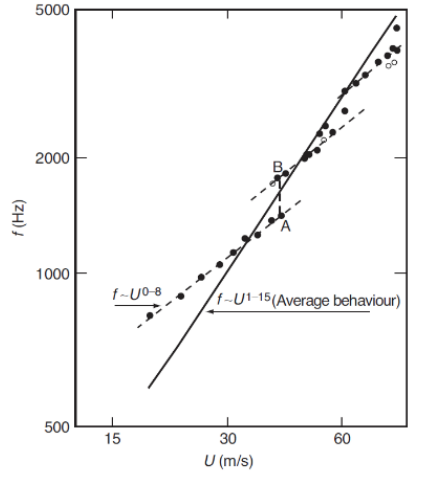
Figure 1. Airfoil ladder-type frequency structure (adapted from Paterson et al. [1]).